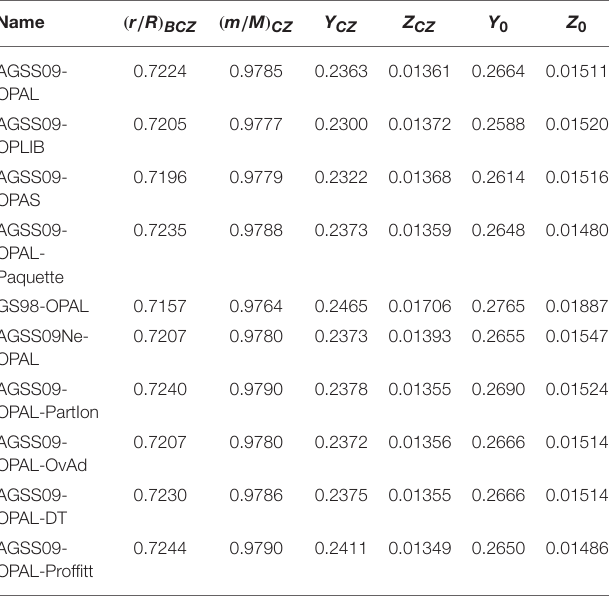
TABLE 2 | Parameters of the standard solar models used in this study.